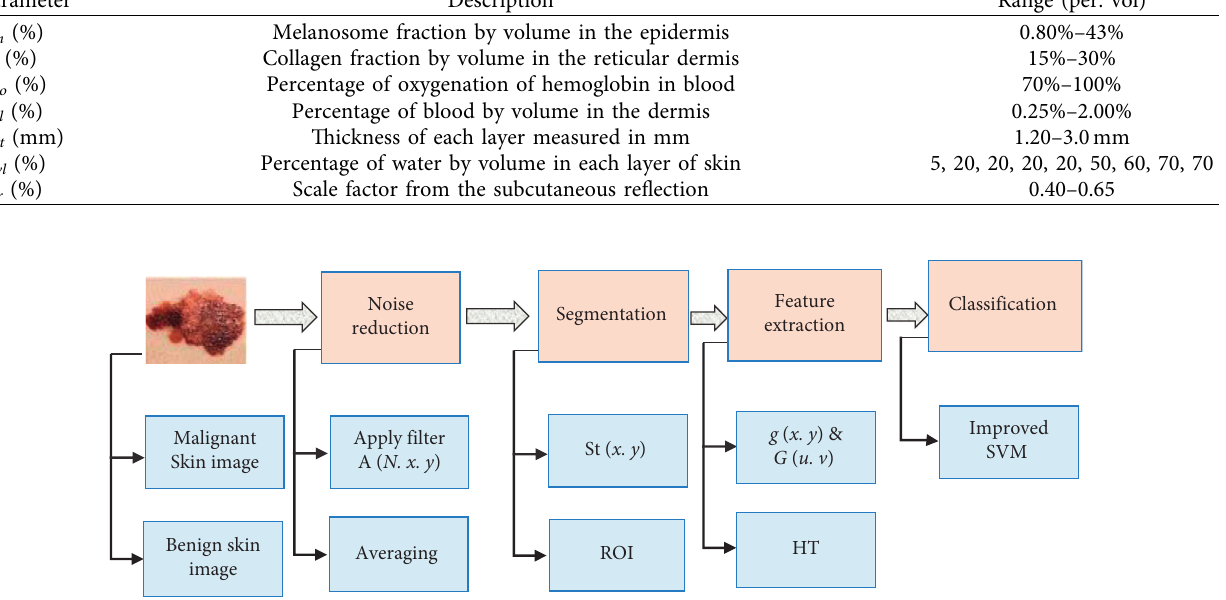
Figure 7: Processes within different stages of the proposed